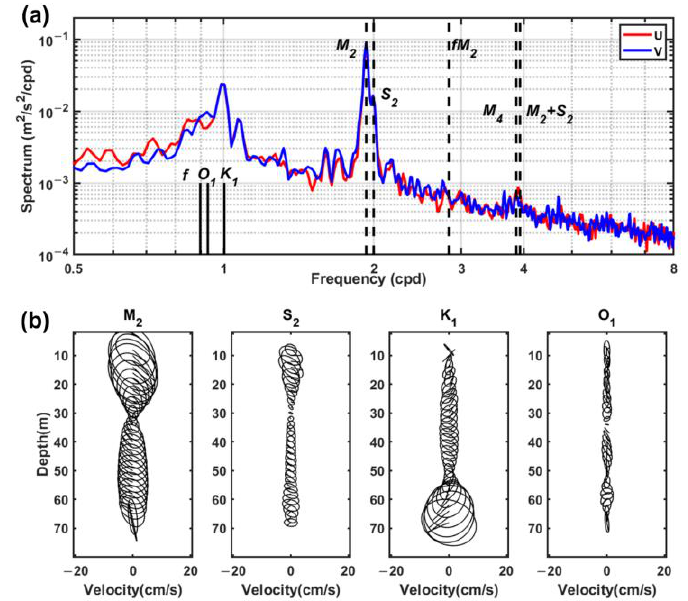
Figure 2. ( a ) Full-depth averaged power spectra of the baroclinic zonal (red line) and meridional (blue line) velocities during the deployment period. The vertical dashed lines indicate the local Coriolis frequency f, four major tidal constituents (O 1 , K 1 , M 2 , S 2 ), and some nonlinear couplings (fM 2 , M 4 , M 2 + S 2 ). ( b ) The internal tidal current ellipses for the four major tidal constituents (M 2 , S 2 , K 1 , and O 1 ) at different depths.